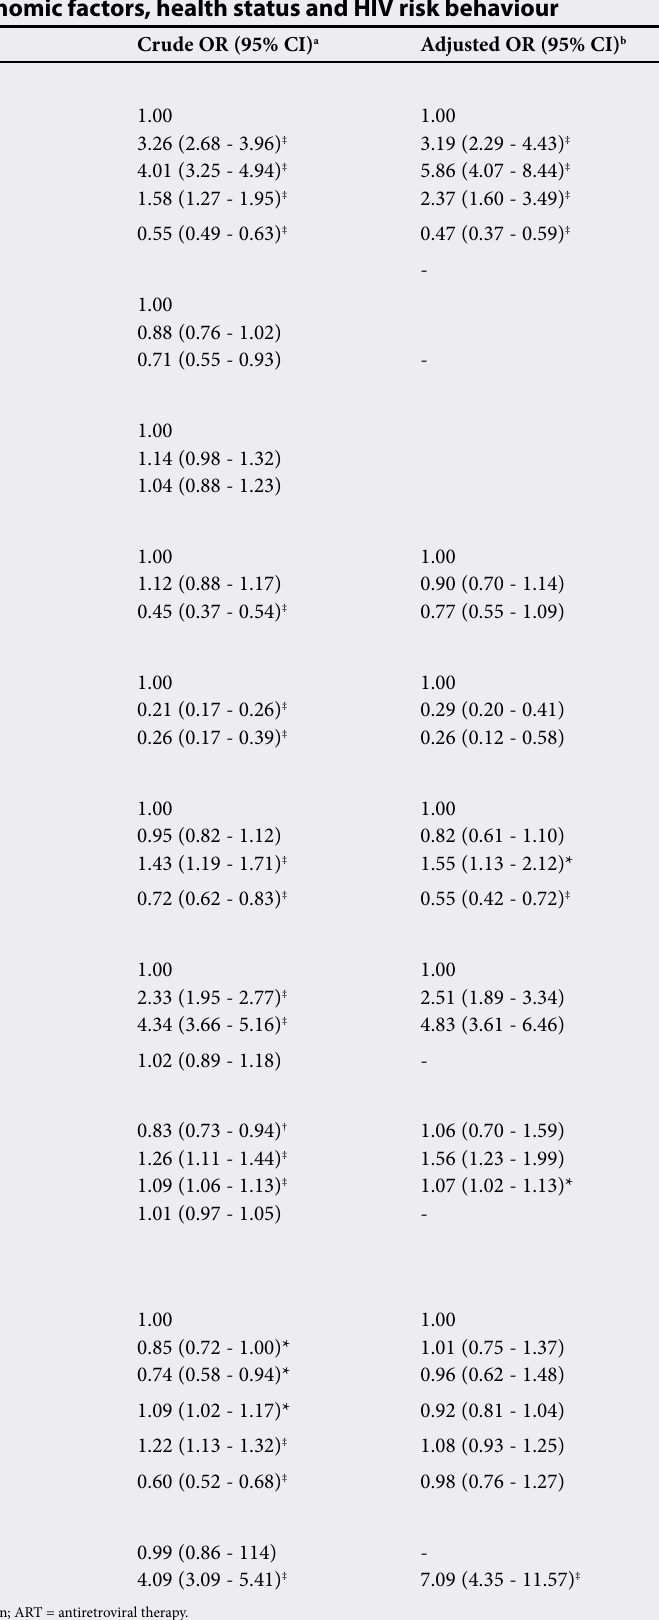
Table 3. Association between HIV status, socioeconomic factors, health status and HIV risk behaviour Socioeconomic factor Crude OR (95% CI) a Adjusted OR (95% CI)